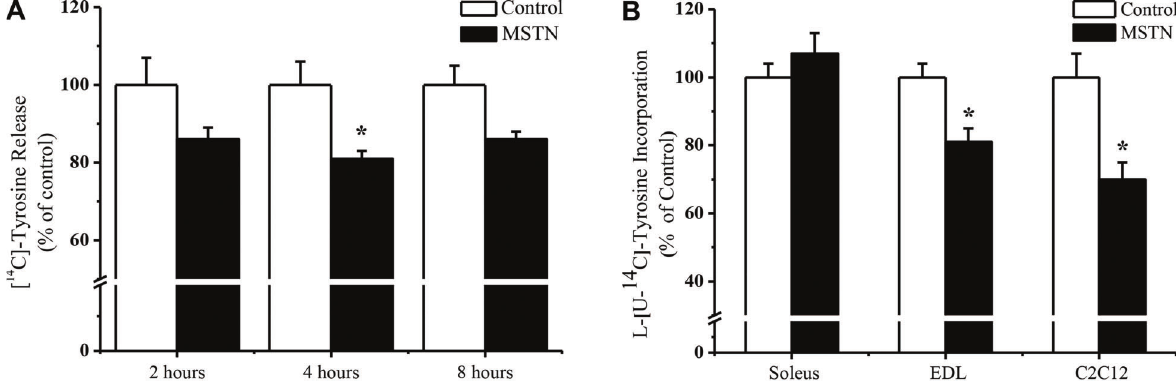
Figure 2. A , Overall proteolysis in C2C12 cells incubated with myostatin (MSTN) (100 ng/mL) after 2, 4, and 8 h. Data are reported as means ± SE of labeled tyrosine released into the medium related to total amount of labeled tyrosine incorporated into proteins (%). Control was considered to be 100%, n=5. *P o 0.05 MSTN vs Control (DMEM). B , Rate of protein synthesis in soleus and EDL muscles, and C2C12 cells incubated with MSTN at 100, 10, and 100 ng/mL, respectively, for 4 h. Data are reported as the means ± SE of percentage of tyrosine incorporated into total protein (n=7). Control was considered to be 100%. *P o 0.05 MSTN vs Control, t -test.